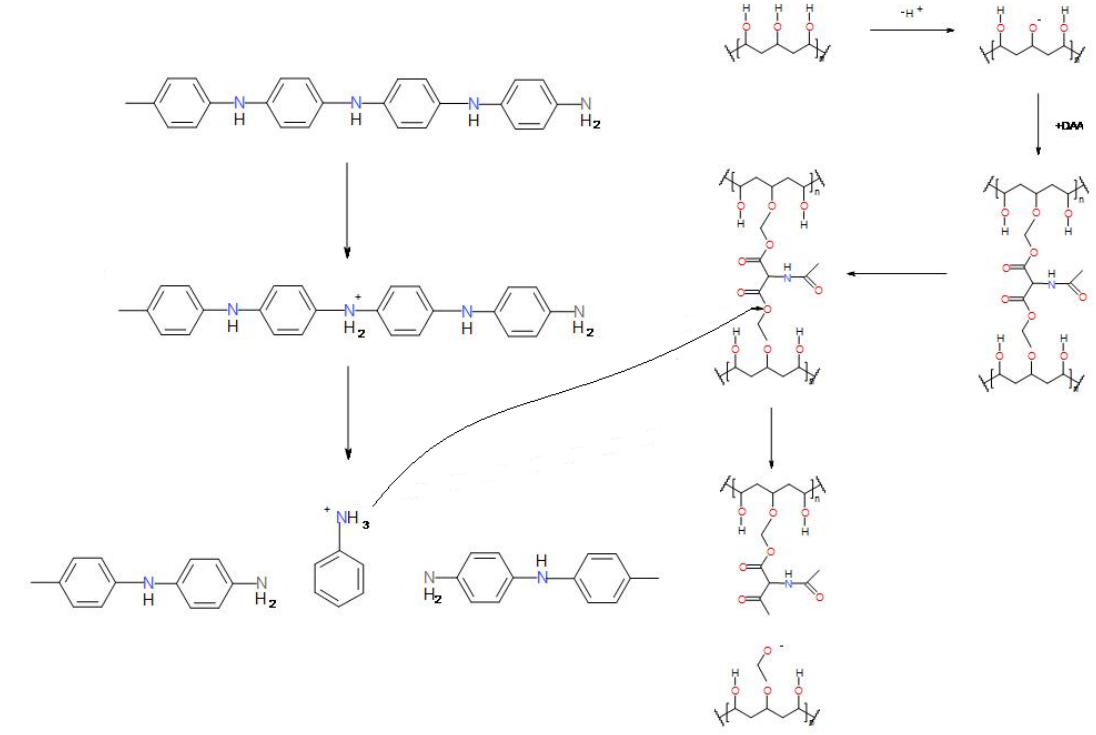
Figure 5. The mechanism of ECH erosion as observed via interactive chemical reactivity.